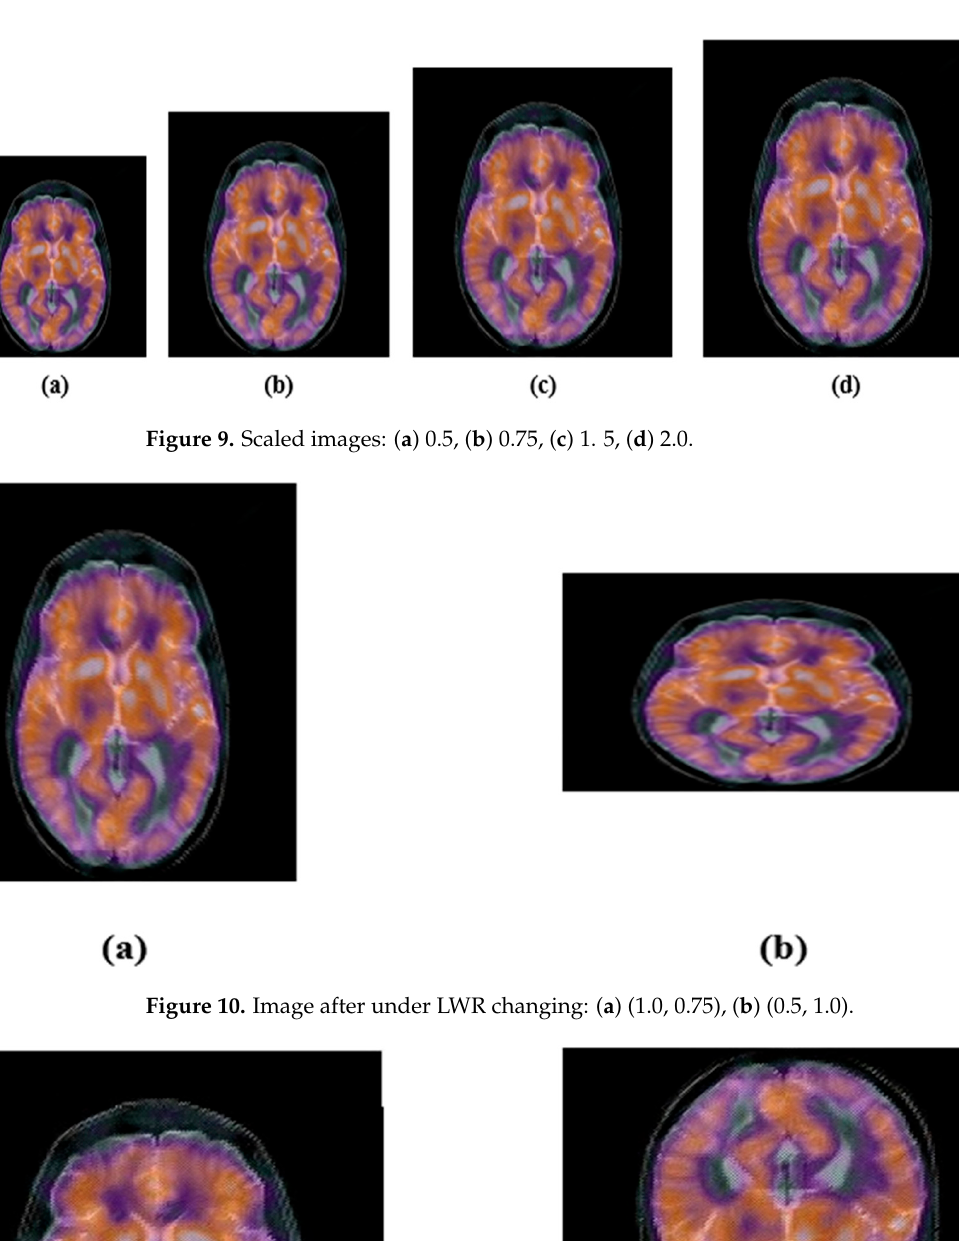
Figure 8. Rotated Images: ( a ) 5°; PSNR = 16.5233; ( b ) 15°; PSNR = 15.1828; ( c ) 25°; PSNR = 14.3906; ( d ) 45°; PSNR = 13.6059.